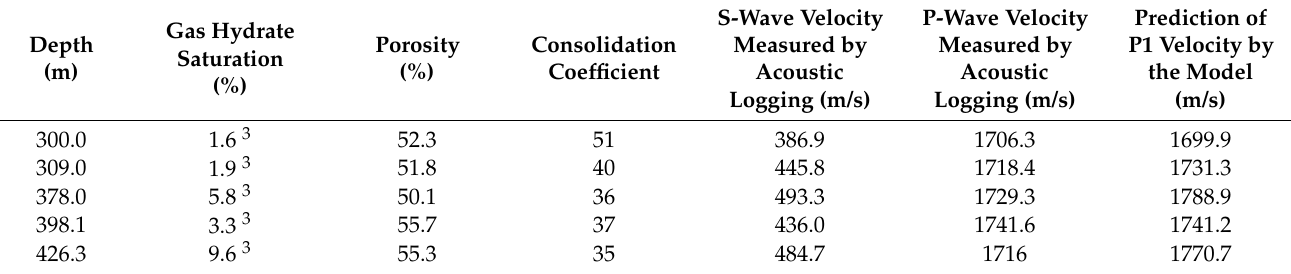
Figure 7. Comparison between the acoustic well log velocities and theoretically predicted velocities at ODP Leg 164 Site 995B. Table 2. Measured data and P-wave predicted by the